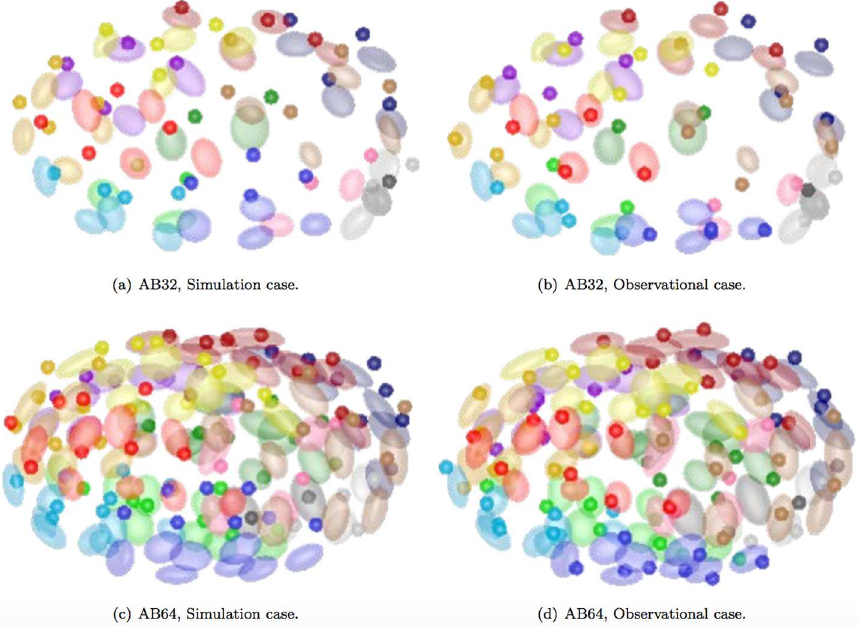
Fig 7. Cell position validation. Stages of AB32 and AB64 mean when the AB lineagedividesinto 32 and 64 cells. Color-coded rule is the same as in Fig 6. Dots represent the exact cell positionsin a specific simulation/ observational case, and ellipsesrepresent the averageposition of each coresponding cell (with one standard